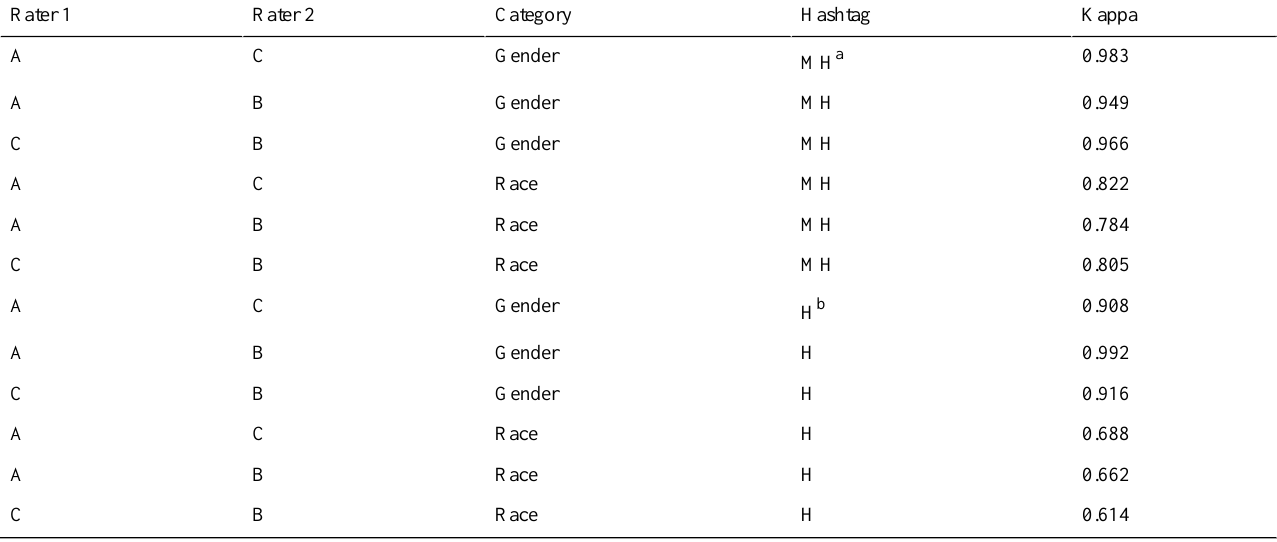
Table 4. Kappa interrater agreement by rater pair, category, and